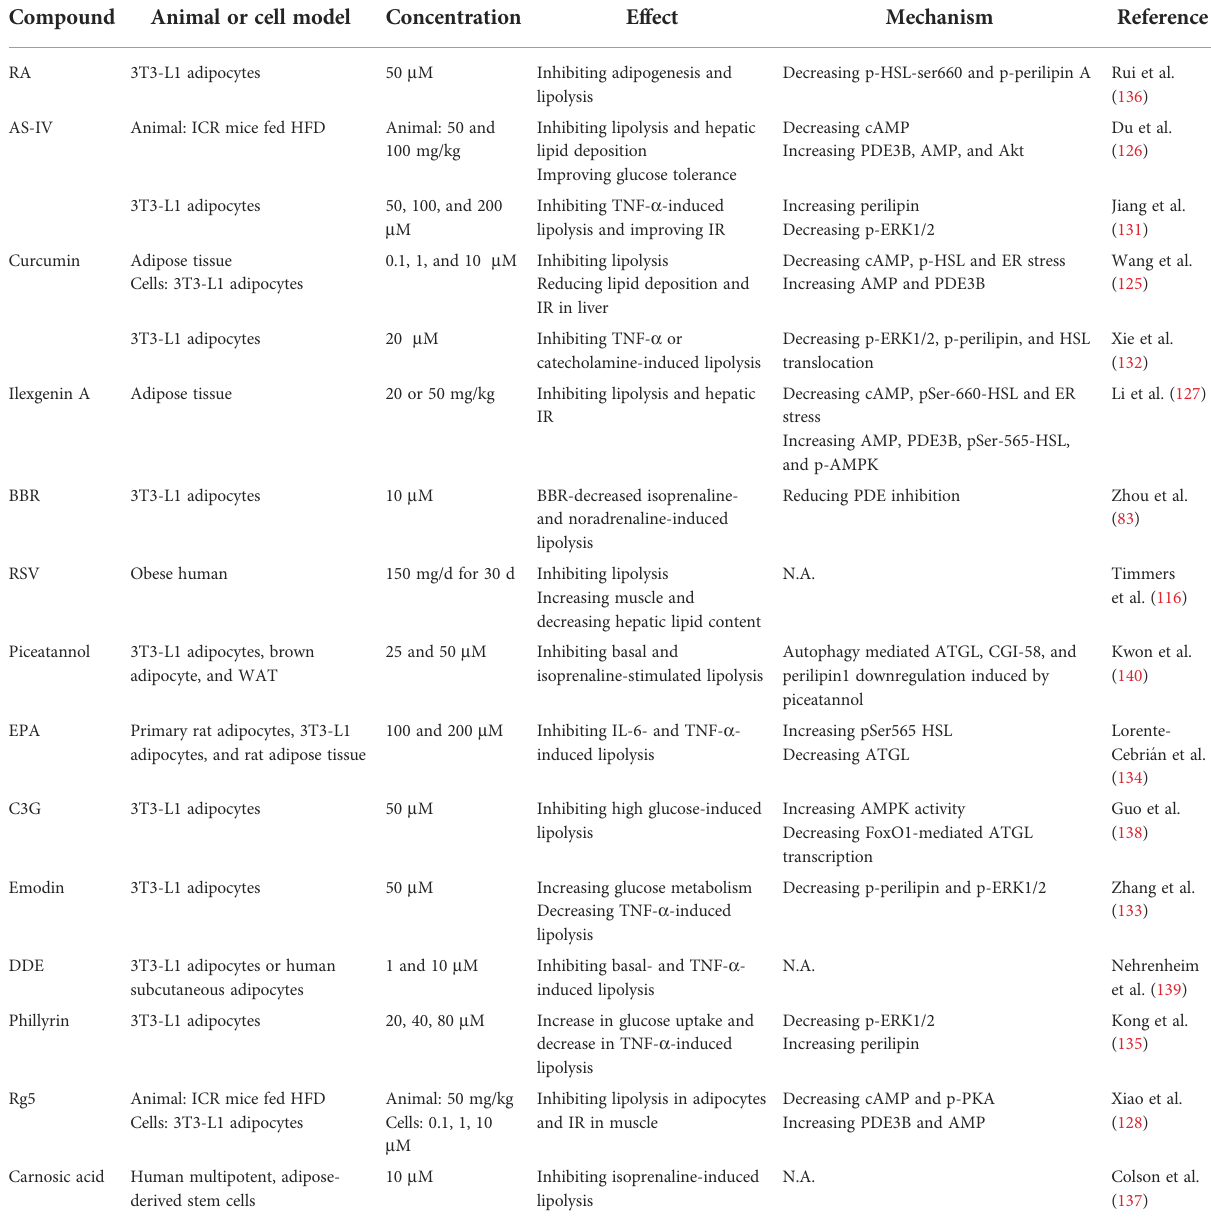
TABLE 5 Anti-lipolytic effects and mechanisms of various compounds. Compound Animal or cell model Concentration